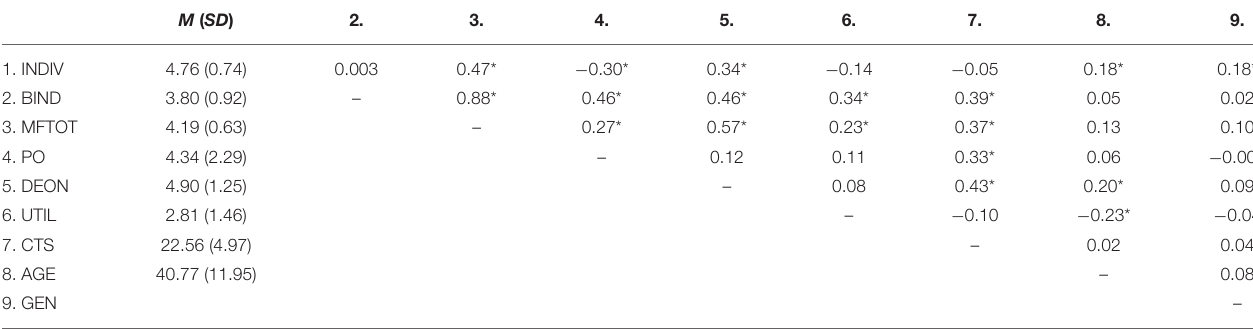
TABLE 2 | Study 1 means, standard deviations, and correlations of the variables.